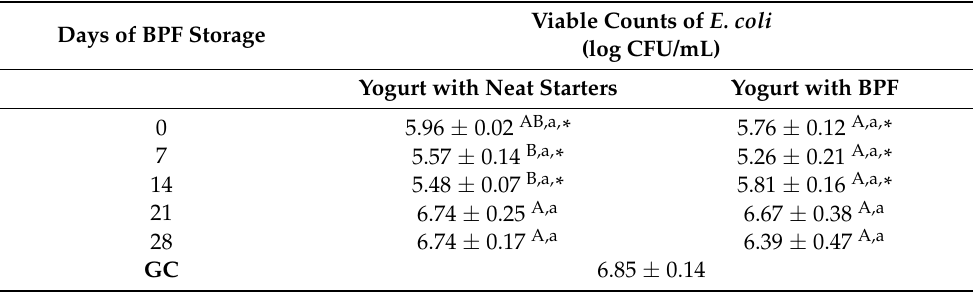
Table 3. In situ anti- Escherichia activity of yogurt samples fermented with neat starters and granulated BPF as a premix in comparison to growth control (GC). Viable Counts of E. coli Days of BPF Storage (log CFU/mL) Yogurt with Neat Starters Yogurt with BPF 0 5.96 ± 0.02 AB,a,